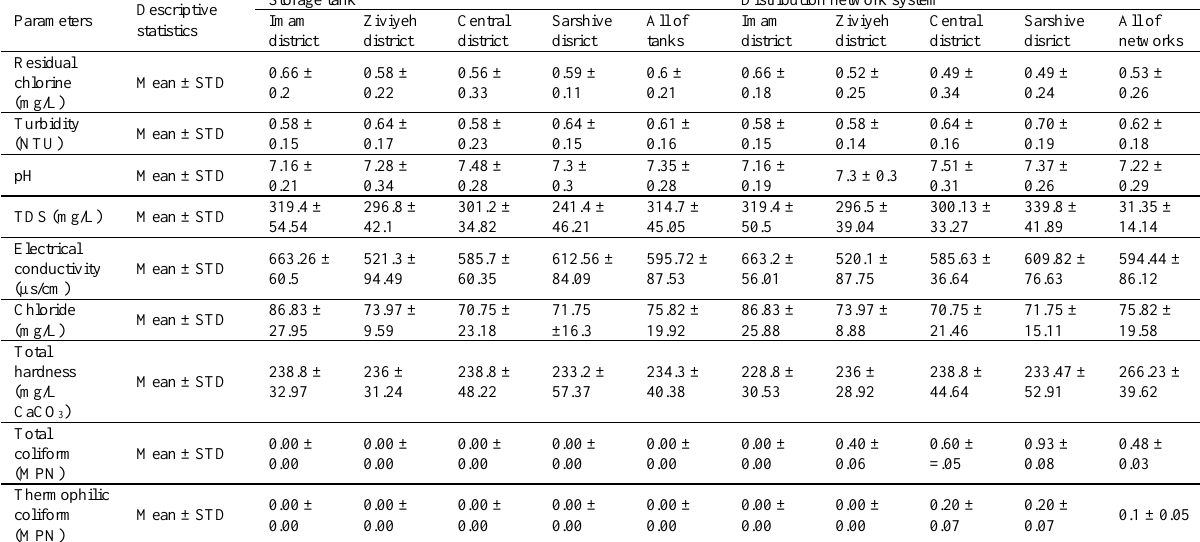
Table 1. Descriptive statistics of water storage tanks, distribution networks, and city districts